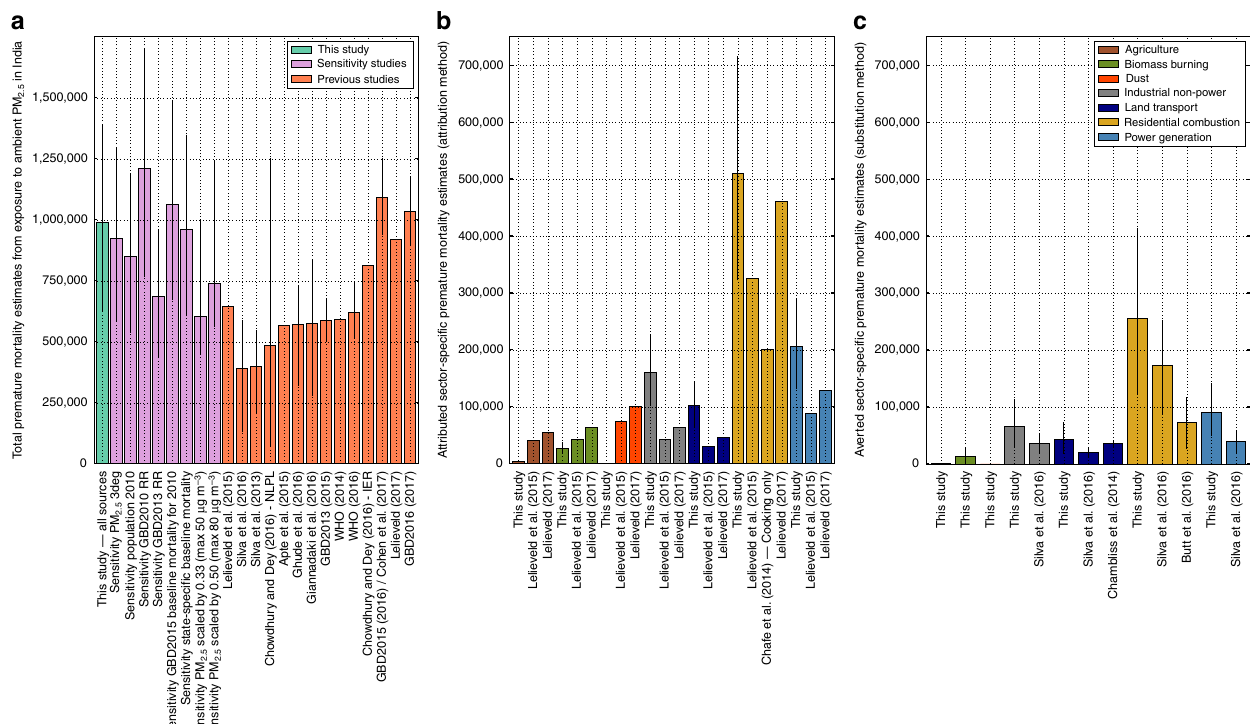
Fig. 4 Comparison of annual premature mortality estimates for India due to exposure to ambient PM 2.5 . a Total annual premature mortality from exposure to ambient PM 2.5 from all emission sources. This study (green) and sensitivity studies (purple) comparing varying model spatial resolution, population year, exposure – response function, baseline mortality rates and PM 2.5 concentrations are compared with previous studies (orange). b Attributed sector- speci fi c estimates from the attribution method from this study compared to previous studies. c Averted sector-speci fi c estimates from the substitution method from this study compared to previous studies. Error bars for this study and sensitivity analyses represent 95% uncertainty intervals (95UI) calculated from combining fractional errors in quadrature (see Methods). Error bars for previous studies given at the 95% uncertainty level where provided